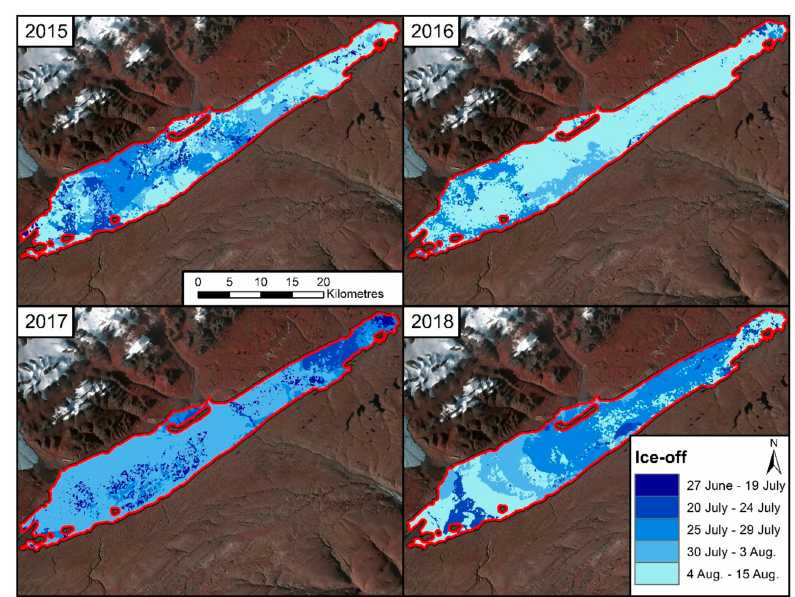
Figure 9. Ice-o ff dates for Lake Hazen, determined on a pixel by pixel basis using the first di ff erence method, from 2015–2018. Landsat-8 Level-1 image courtesy of the U.S. Geological Survey (Digital Object Identifier (DOI) number: / 10.5066 / F71835S6).